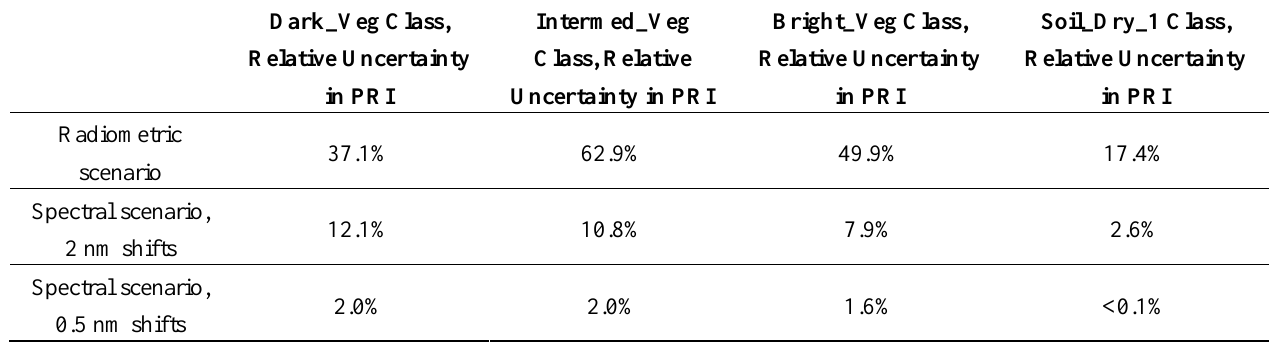
Table 5. Relative uncertainty of the PRI for selected